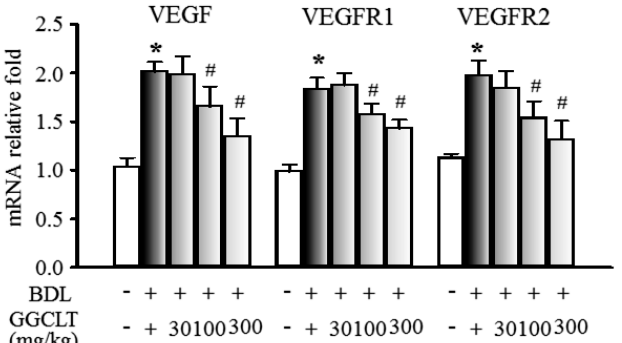
Figure 6. Effects of GGCLT on hepatic levels of HIF-1 α and angiogenesis-regulated factors in BDL mice. The quantitative real-time PCR results show the mRNA levels of vascular endothelial growth factor (VEGF), VEGFR1, and VEGFR2 in the liver tissues. The data presented are the mean ± SEM from three independent measurements. * p < 0.05 vs. sham-control mice; # p < 0.05 vs. BDL mice.